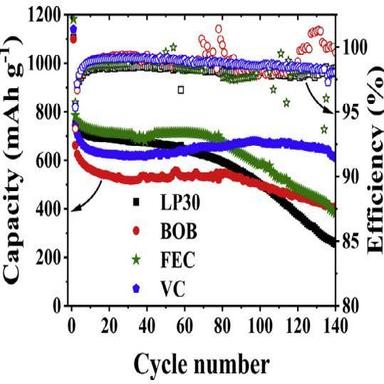
Cycling behavior of the galvanostatic cycling test performed on Li/LP30 + 2% additive/Co3O4 cells. In black the pristine electrolyte, in blue the VC added electrolyte, in red the LiBOB added electrolyte and in green the FEC added electrolyte.